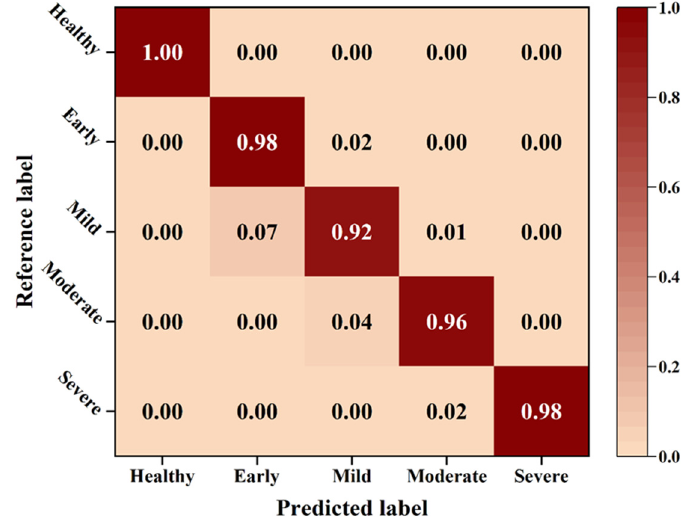
Figure 9. Confusion matrices for apple Alternaria leaf blotch severity classification.